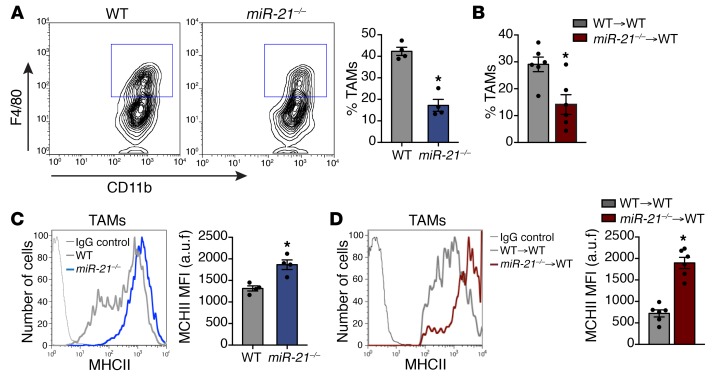
TAMs of miR-21–/– or WT mice adoptively transferred with miR-21–/– BM have an enhanced differentiated phenotype.(A) Left panel: Representative flow cytometry plots of TAM detection in s.c. LLC tumors of WT and miR-21–/– mice. TAMs were gated as CD45+ CD11b+ MHC II+ F4/80+ cells of the digested tumor. Right panel: Average % TAMs (n = 4 out of 5 randomly selected). (B) Average % TAMs of LLC tumors in WT mice transplanted with WT or miR-21–/– BM cells (n = 6 out of 7 randomly selected). (C and D) Representative histograms of MHC II surface expression in TAMs of s.c. LLC tumors of WT or miR-21–/– (C), or WT mice transplanted with WT or miR-21–/– BM cells (D) a.u.f., arbitrary units of fluorescence. Right panels: Average MFI (n = 4 out of 5 randomly selected for C or n = 6 out of 7 randomly selected for D). Results are mean ± SEM. (A–D) *P < 0.05, Mann-Whitney U test. (A and D) Representative experiments out of 3 with similar results. (B and D) Representative experiments out of 2 with similar results.